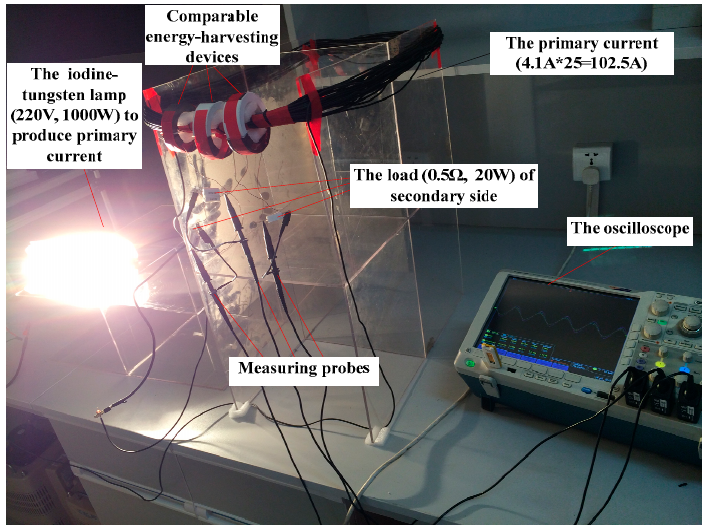
Figure 9. Experimental system for optimal design of the energy harvesting device. Table 1. Comparative experimental parameters of nine energy harvesting devices ( I 1 = 102.5 A, R L = 0.5 Ω ).